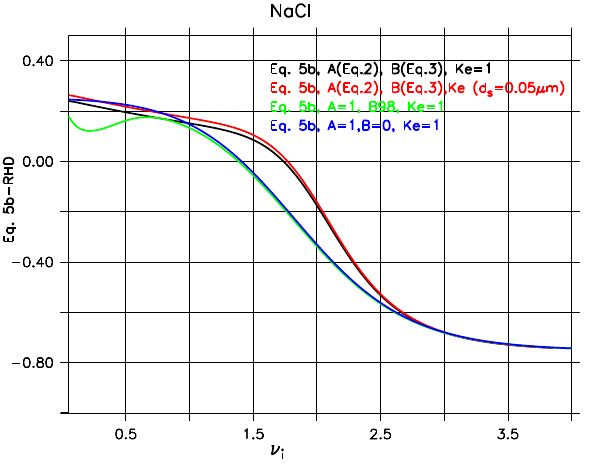
Fig. 10. ν i values for ( NH 4 ) 2 SO 4 , satisfying “Eq. (5b)-RHD” using a root-finding